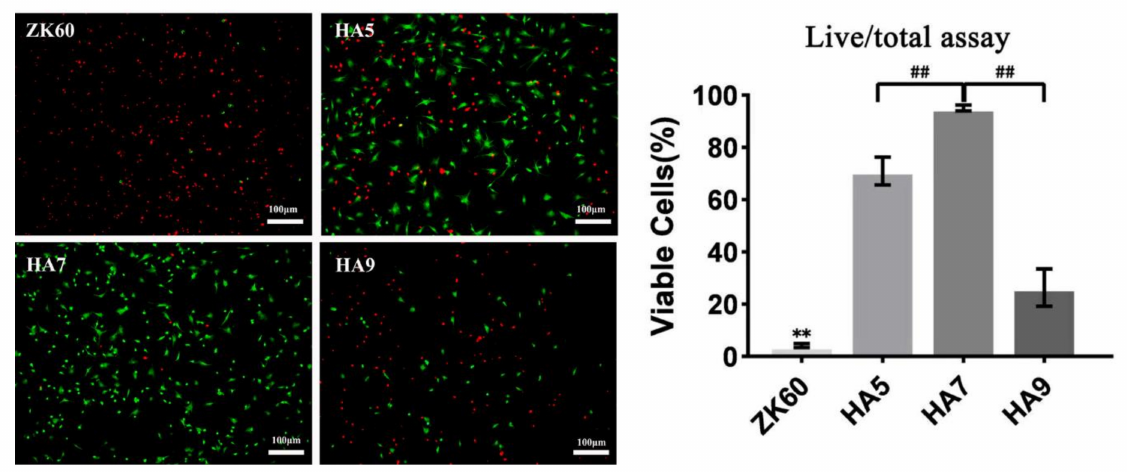
Figure 9. Fluorescence images of the bone marrow stem cells (BMSCs) and the statistical results of percentage of live cells after 24 h culture. (** represents p < 0.01 compared with other groups ## represents p < 0.01).